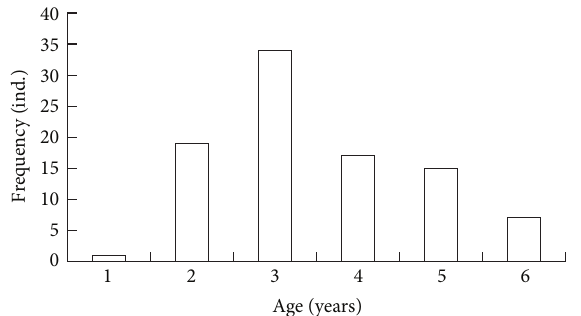
Figure 3: Age distribution of the Ruditapes bruguieri sample from the eastern coast of Jeju Island.